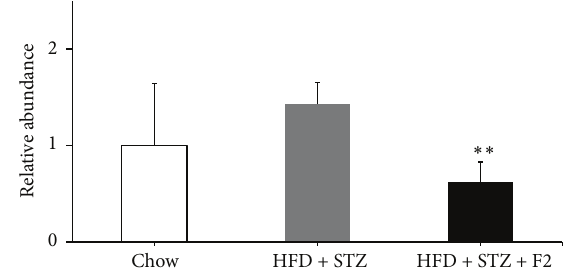
Figure 4: Effect of F2 on hepatic gluconeogenic gene. mRNA expression levels by qRT-PCR of glucose-6-phosphatase (G6P) in hepatic tissue of ethyl acetate fraction (F2) treated diabetic mice. HFD + STZ: diabetic control group and HFD + STZ + F2: diabetic group given 10 IP doses of F2. ( 𝑛 = 6 .) ∗∗ 𝑝 < 0.05 versus HFD + STZ group. Values are expressed as mean ±